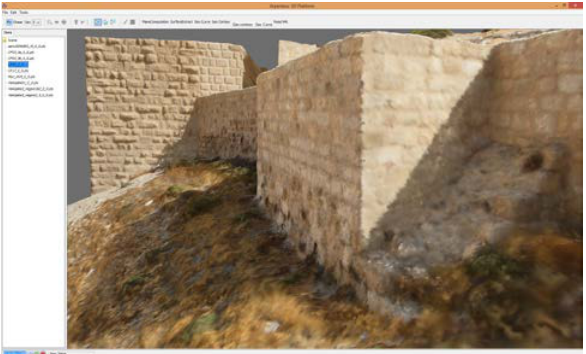
Figure 8 The 3D platform main interface (view of a wall of the Shawbak Castle,